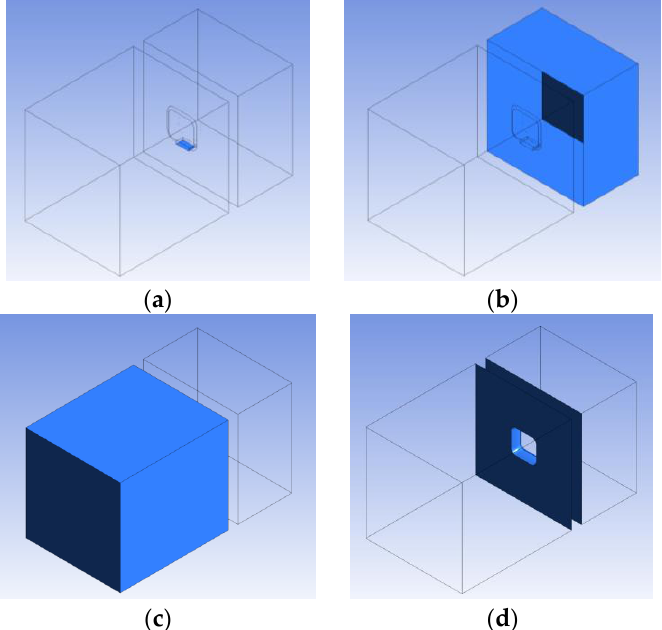
Figure 8. Areas with boundary conditions (highlighted in blue) in the analysis model. ( a ) The runner inlet of the window-type convection device, ( b ) the flow-field inlet, ( c ) the flow-field outlet, and ( d ) the wall surface.